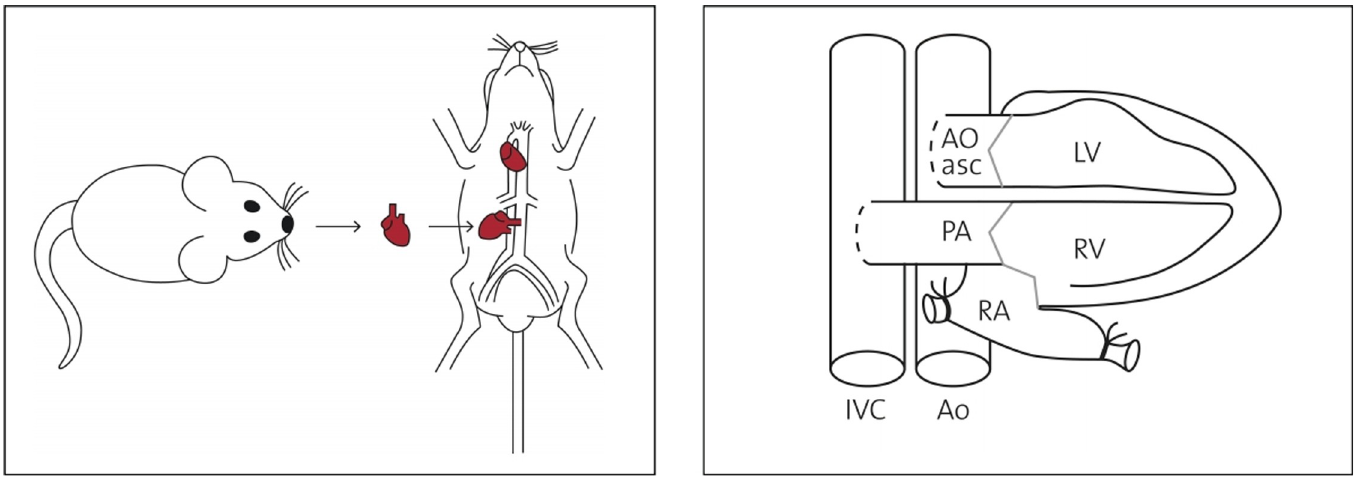
Fig 1. Schematic illustration of the heterotopic abdominal heart transplantation (a) and of the anastomoses (b). The donor ascending aorta (Ao asc) was anastomosed to the recipient infrarenal aorta (Ao), and the donor pulmonary artery (PA) was anastomosed to the recipient inferior vena cava (IVC). Due to the absence of atrial filling, and in the presence of competent aortic and pulmonary valves, the left and the right ventricle (LV, RV) are mechanically unloaded.